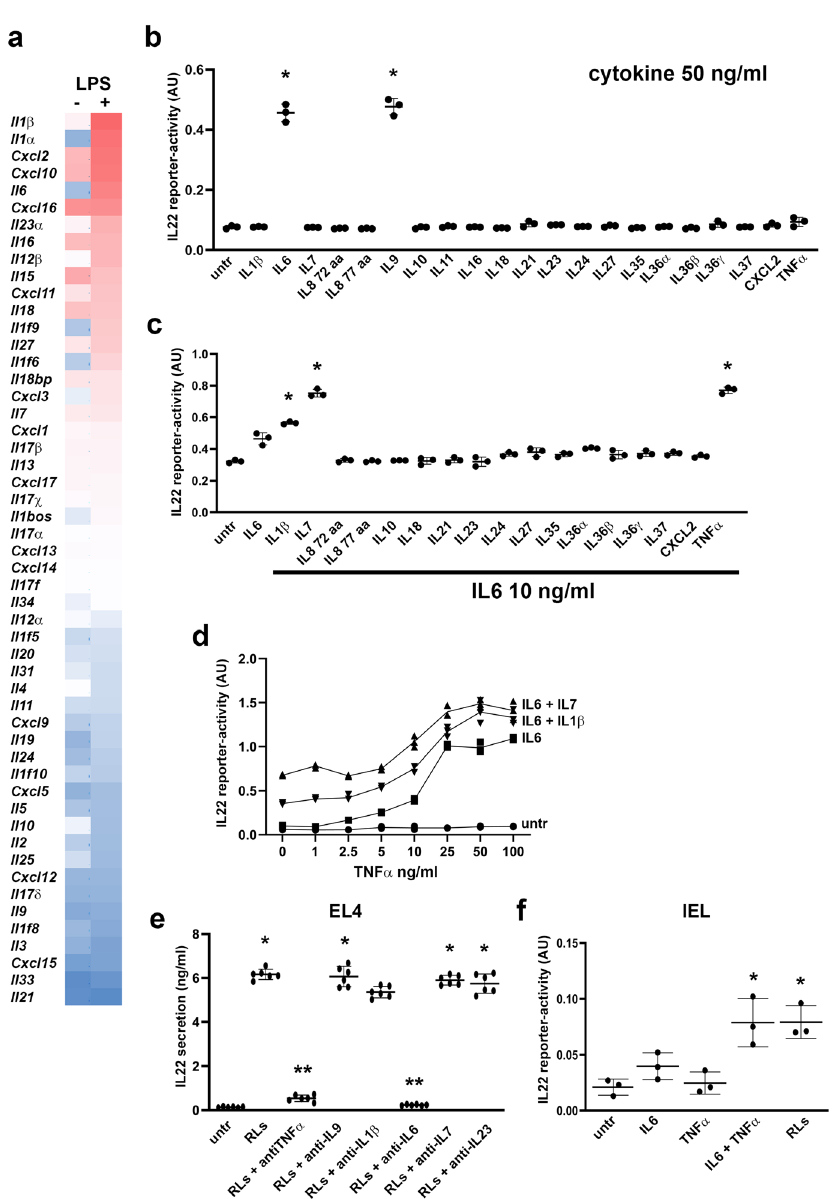
Fig. 4 IL22 secretion and expression in EL4 T cells is induced by IL6 and enhanced by either IL7 or TNF α and/or IL1 β . a Cytokine mRNA expression in LPS-stimulated RAW264.7 cells. b IL22 reporter-activity of supernatants from EL4 T cells stimulated with indicated cytokines at concentrations of 50 ng/ ml. c IL22 reporter-activity of supernatants from EL4 T cells stimulated with IL6 combined with indicated cytokines at concentrations of 10 ng/ml. d IL22 reporter-activity of supernatants from EL4 T cells stimulated with IL6 (10 ng/ml) combined with either IL1 β (10 ng/ml) or IL7 (5 ng/ml) and TNF α (with indicated concentrations). e IL22 expression in EL4 T cells after 48 h exposure to supernatants from LPS-stimulated RAW264.7 cells (RLs) in the presence or absence of indicated blocking antibodies. f IL22 reporter-activity of supernatants from freshly isolated IEL cells stimulated with either IL6 or TNF α , or IL6 and TNF α combined (10 ng/ml), or stimulated with supernatant from LPS-stimulated RAW264.7 cells. All experiments were performed in triplicate with a minimum of three independent experiments. All data are shown as mean ± SD. For statistical analyses, Log2 transformed data were used in Welch and Brown – Forsythe tests followed by Dunnett ’ s T3 multiple comparisons test. * P < 0.05 was considered to indicate statistical signi fi cance. ** P < 0.05. compared to RLs stimulated